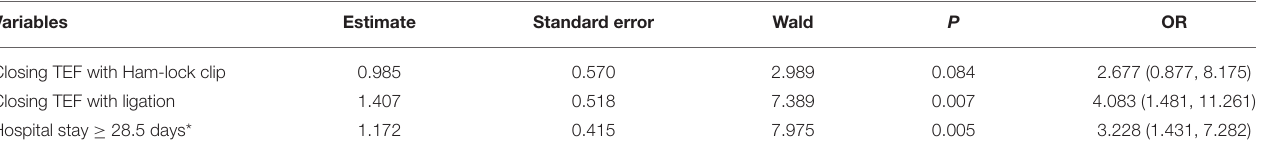
TABLE 2 | Multivariate logistic regression analysis of prediction of